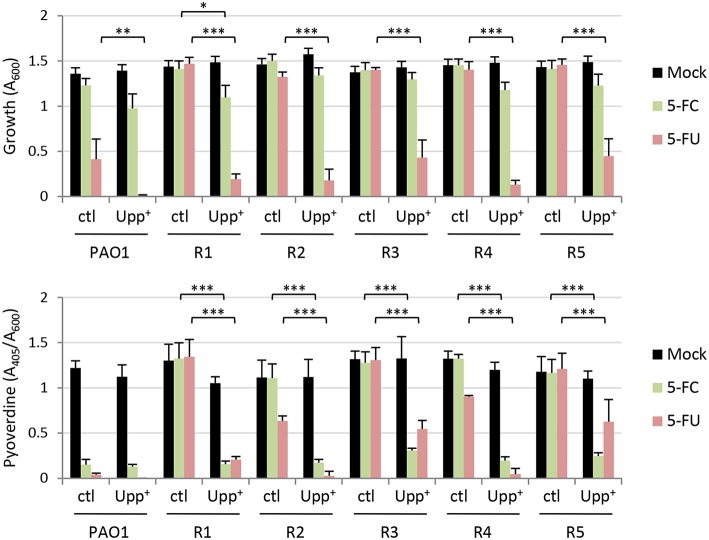
Effect of 5-fluorocytosine (5-FC) and 5-fluorouracil (5-FU) supplemented at 100 μM on growth and relative pyoverdine production (upper and lower panel, respectively) of P. aeruginosa PAO1 and five isogenic spontaneous mutants resistant to 5-FU (R1–R5), containing the empty plasmid pUCP18 (ctl) or the Upp-expressing construct pUCPupp (Upp+). Measurements were taken after 14-h growth in TSBD in microtiter plates at 37°C. Values represent the mean (±SD) of three independent experiments. Asterisks indicate statistically significant differences with respect to the corresponding control carrying the empty plasmid and cultured under the same condition (*P < 0.05, **P < 0.01, ***P < 0.001; ANOVA).